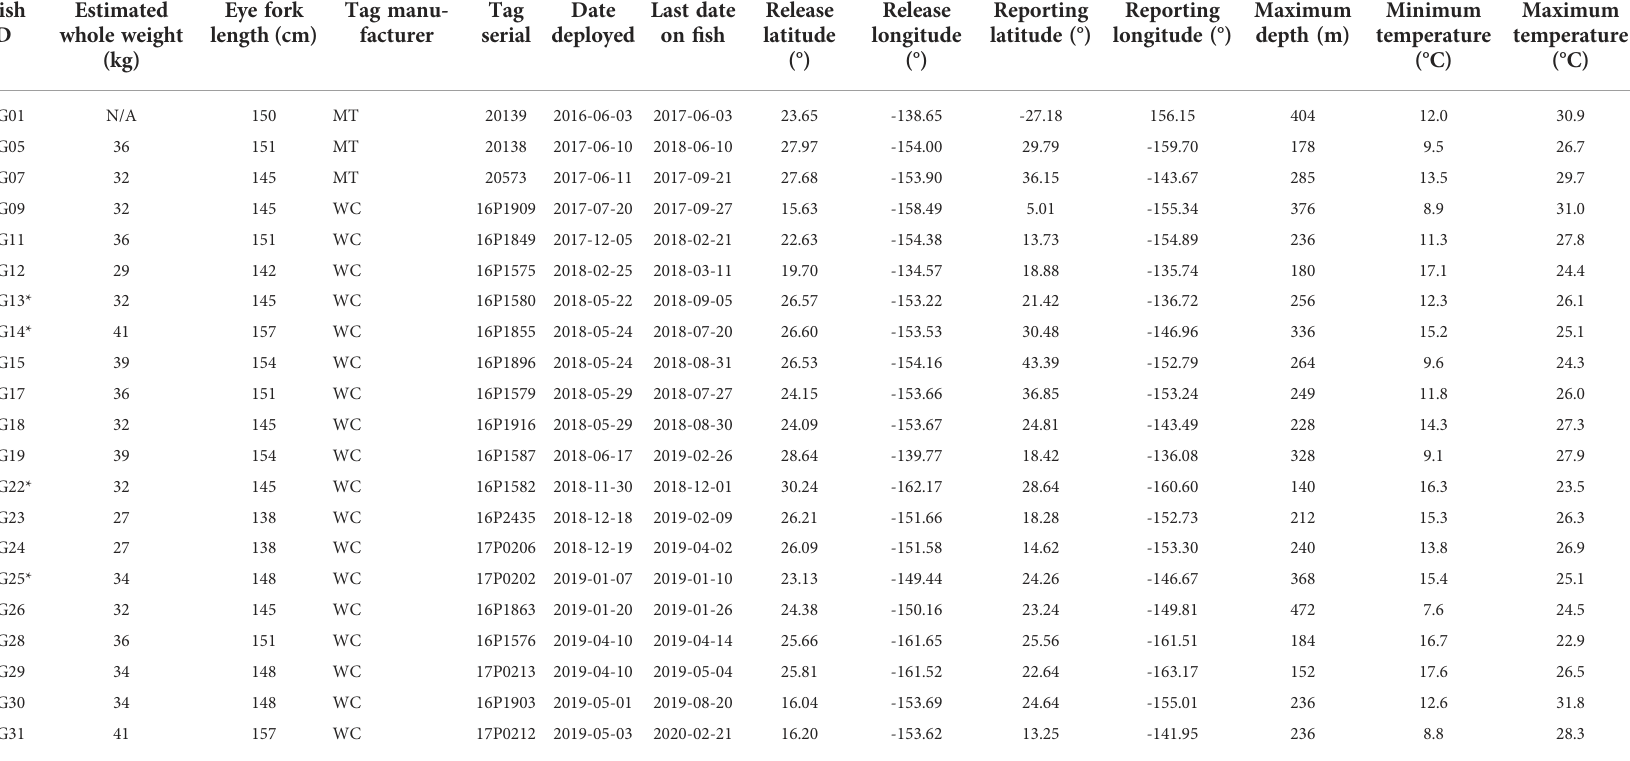
TABLE 1 Tagging and data summary for striped marlin, Kajikia audax